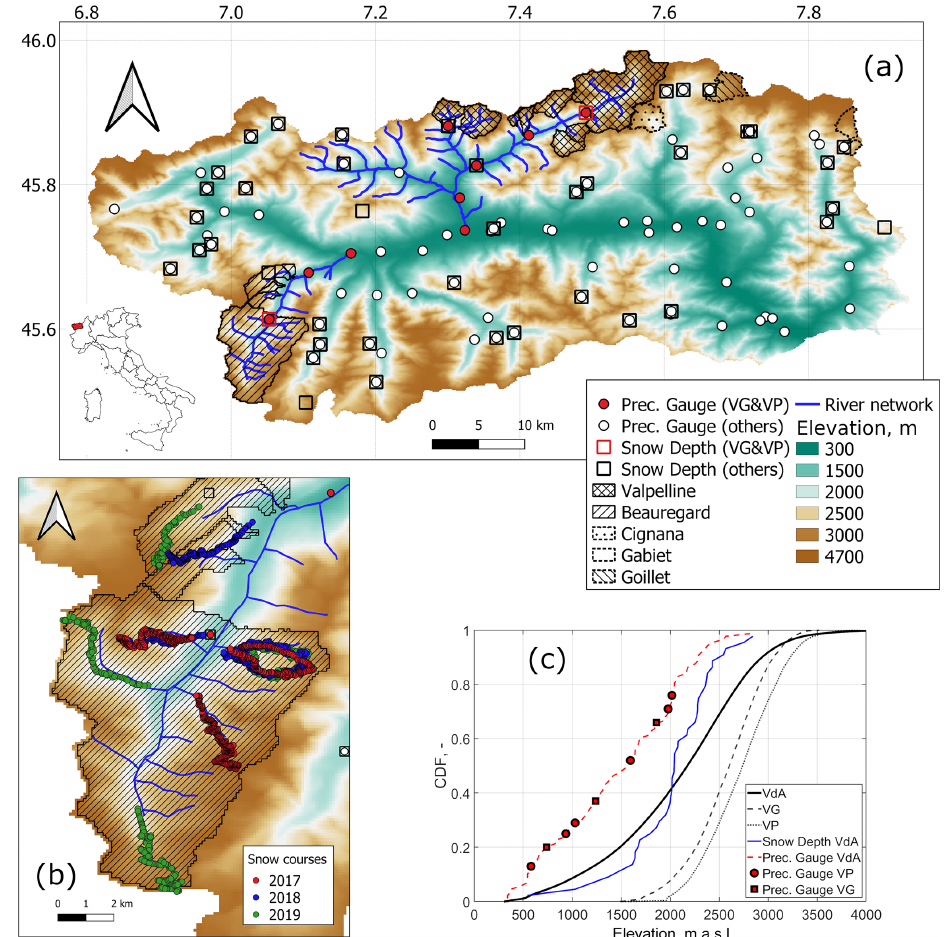
Figure 1. (a) Topography of Aosta Valley (VdA; our focus region), along with hydrography and hydropower catchment delineation of the two valleys for which we reconstructed blended precipitation lapse rates (VG is Beauregard, and VP is Valpelline). This panel also reports the location of all precipitation gauges and snow depth sensors available to the present study, as well as catchment delineation of three other hydropower systems in Aosta Valley where snow courses were collected (see Table 1). (b) Examples of snow course locations for 3 water years at Beauregard. (c) Report on the elevation distribution of the Aosta Valley, Beauregard, and Valpelline and of the precipitation gauge and snow depth sensor